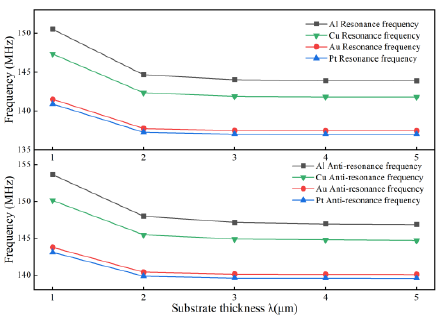
Figure 3. ( a , b ) Symmetrical and anti ‐ symmetrical modes of Al electrode, respectively.